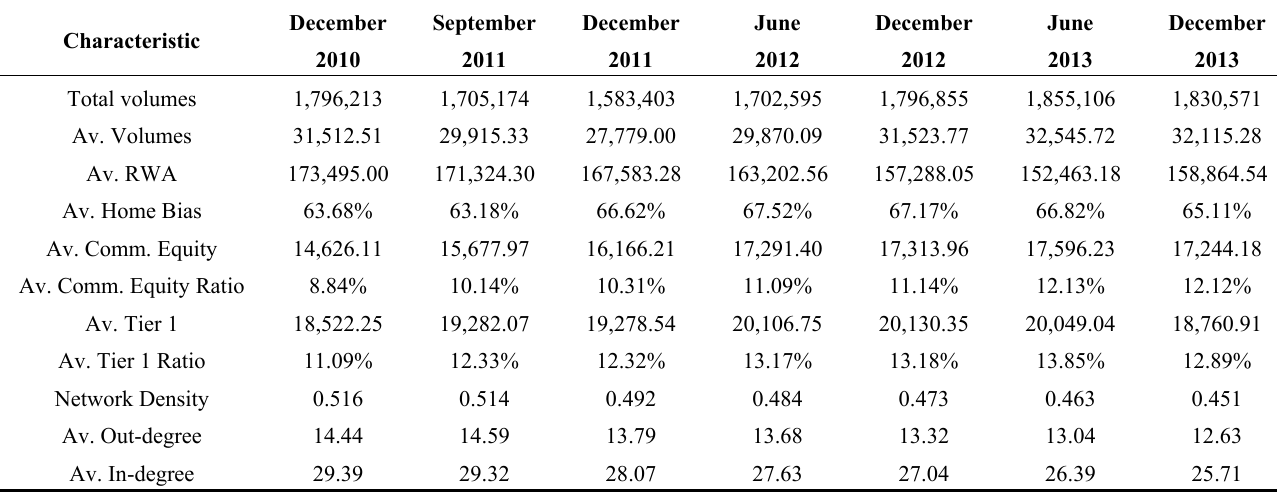
Table 1. Network